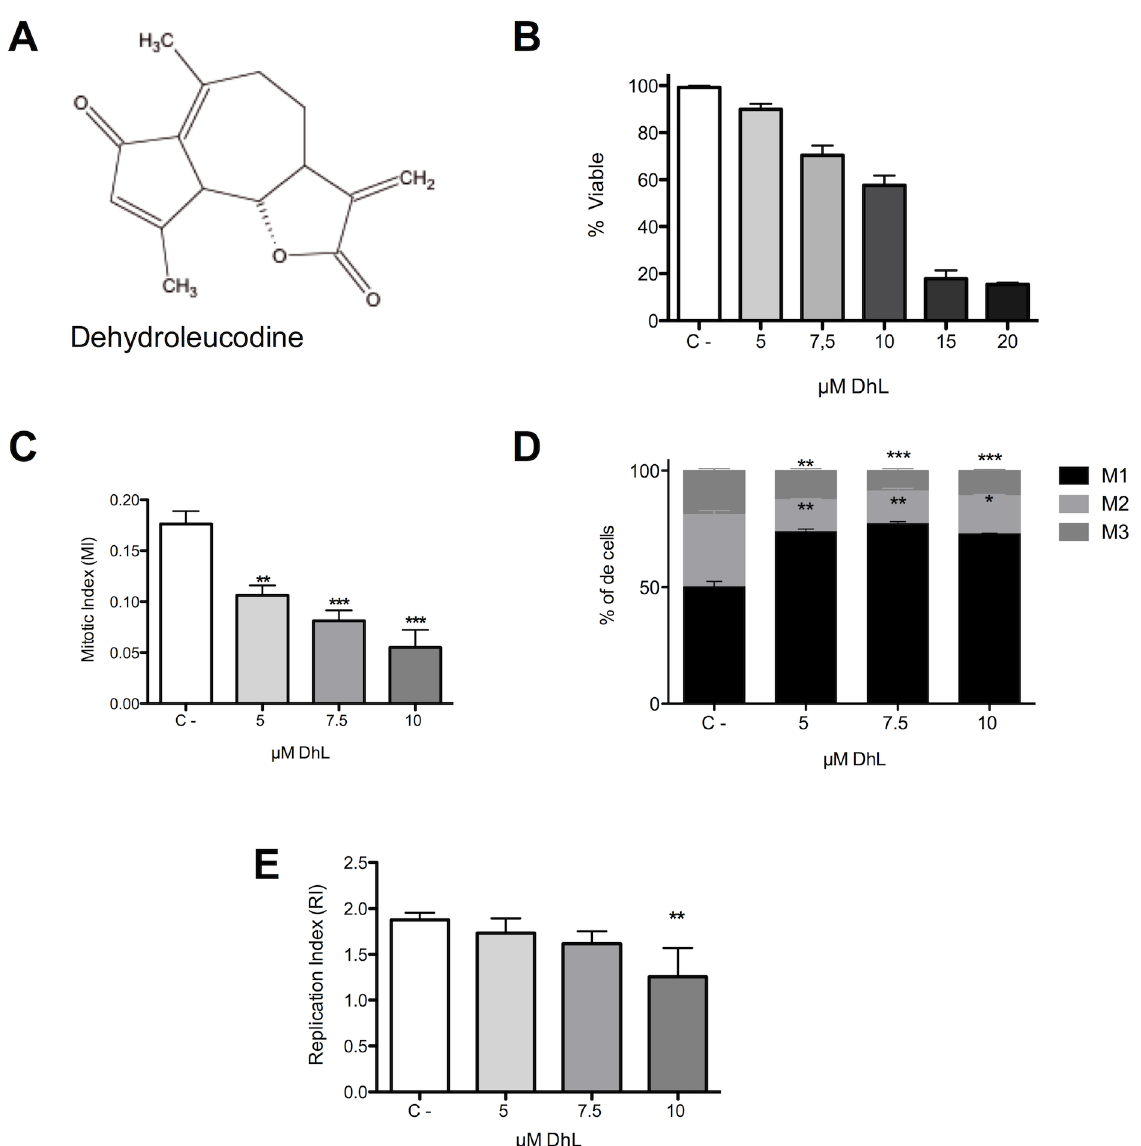
Fig 1. DhL treatment reduced the D384 cell survival. (A). The chemical structure of DhL (B). Analysis of D384 cell viability upon DhL exposure using a MTT assay after 16 h. The x-axis represents the varying concentrations of DhL (5 – 20 μ M), and C- is the control sample without DhL. (C). D384 Mitotic index (MI) measurement upon DhL exposure (5 – 10 μ M). (D). The fraction of D384 cells in 1 mitotic (M1), 2 mitotic (M2) and 3 mitotic (M3) stages after treatment with DhL (5 – 10 μ M, C-, control, DMSO). (E). The replication index (RI) of D384 cells upon exposure to DhL (5 – 10 μ M). Data represent mean ± SEM, n = 3. Symbols denote statistically significant differences: ** p < 0.01, *** p < 0.001 with respect to (C-) control conditions (DMSO).